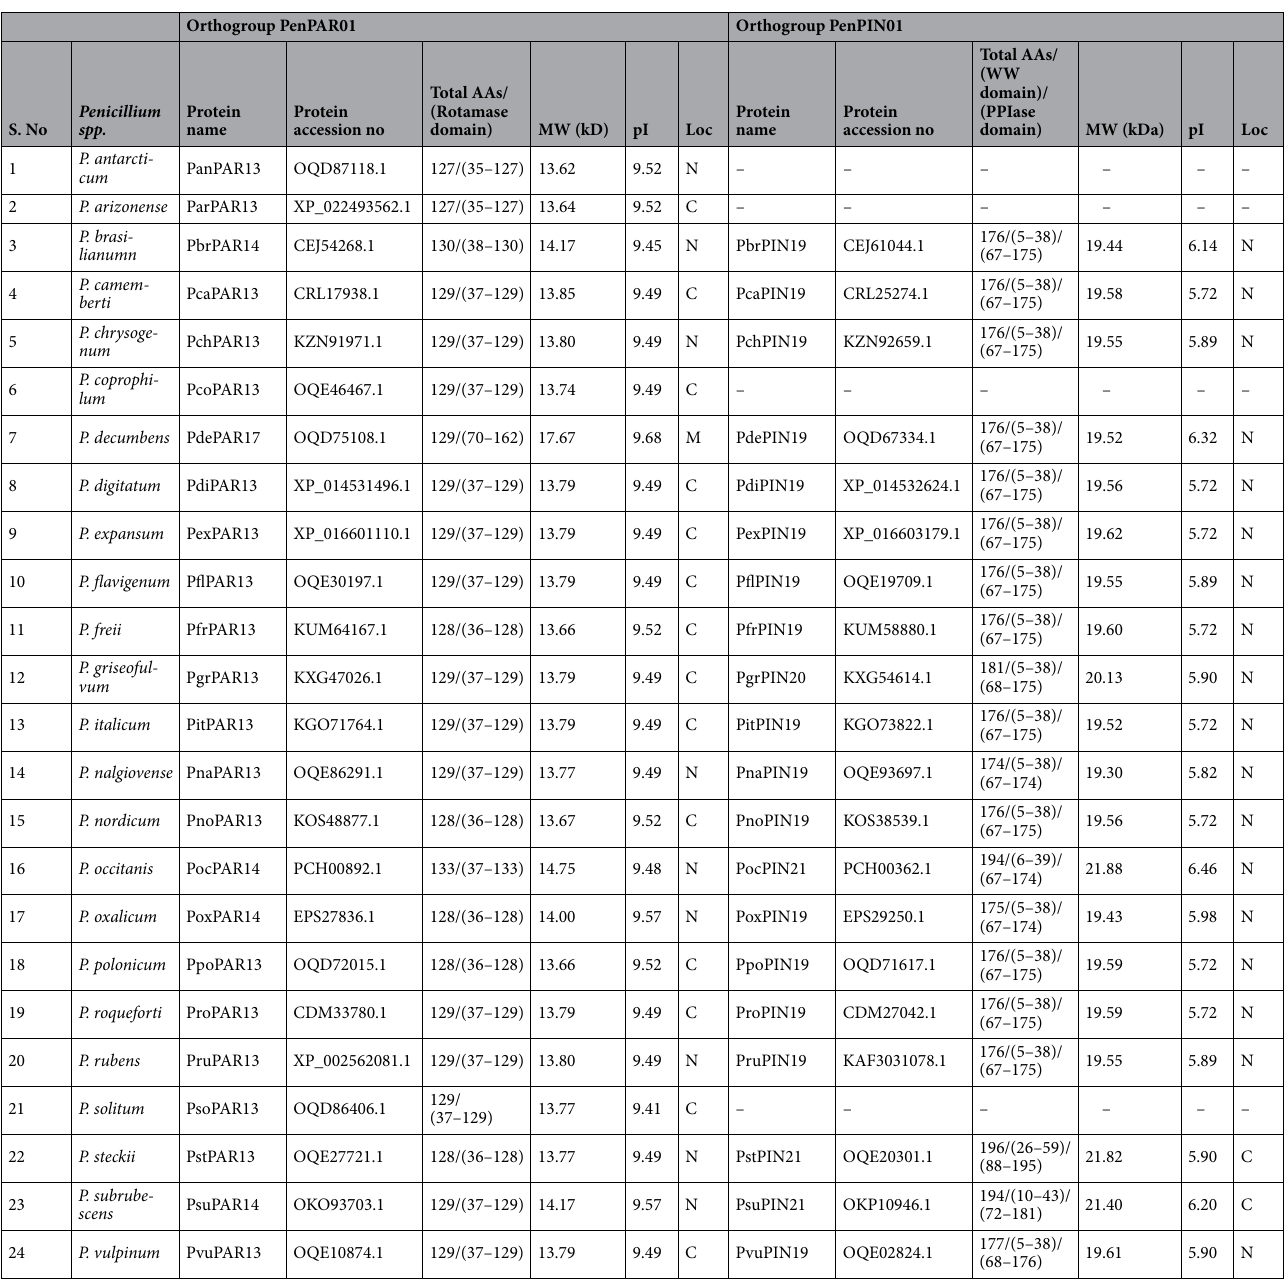
Table 6. Genome-wide analysis of parvulins in different species of Penicillium . AA: amino acids; C: cytoplasm; kDa: kilodalton; Loc: subcellular localization; M: mitochondria; MW: molecular weight; N: nucleus; pI: isoelectric point; WW: Domain with 2 conserved tryptophan